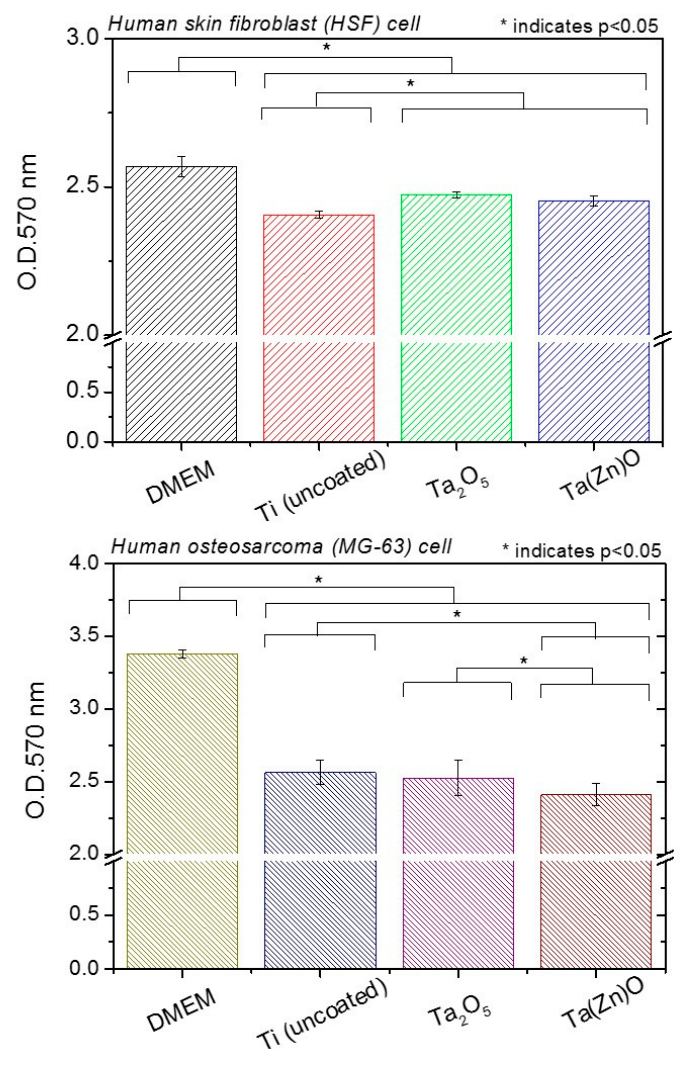
Figure 7. The cytotoxic effect of the uncoated Ti, Ta 2 O 5 , and Ta(Zn)O films on HSF and MG-63 cells compared to the regular culture medium (DMEM) according to the ISO 10993-5 methodology. The mean vales of O.D. were different significantly among all samples ( p < 0.05). Post-hoc pairwise comparisons were conducted by the Turkey test and the differences were considered significant when p < 0.05.